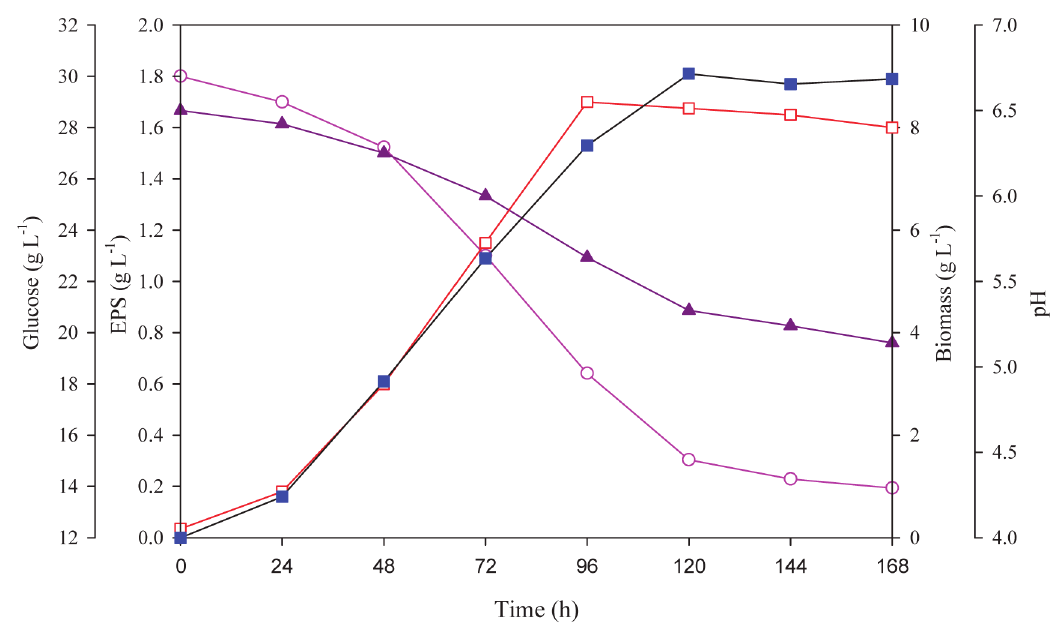
Fig. 2 – Time courses of submerged culture of H. marmoreus in 5-L fermenter under non-pH control. EPS (■), biomass (□), pH (▲), and glucose